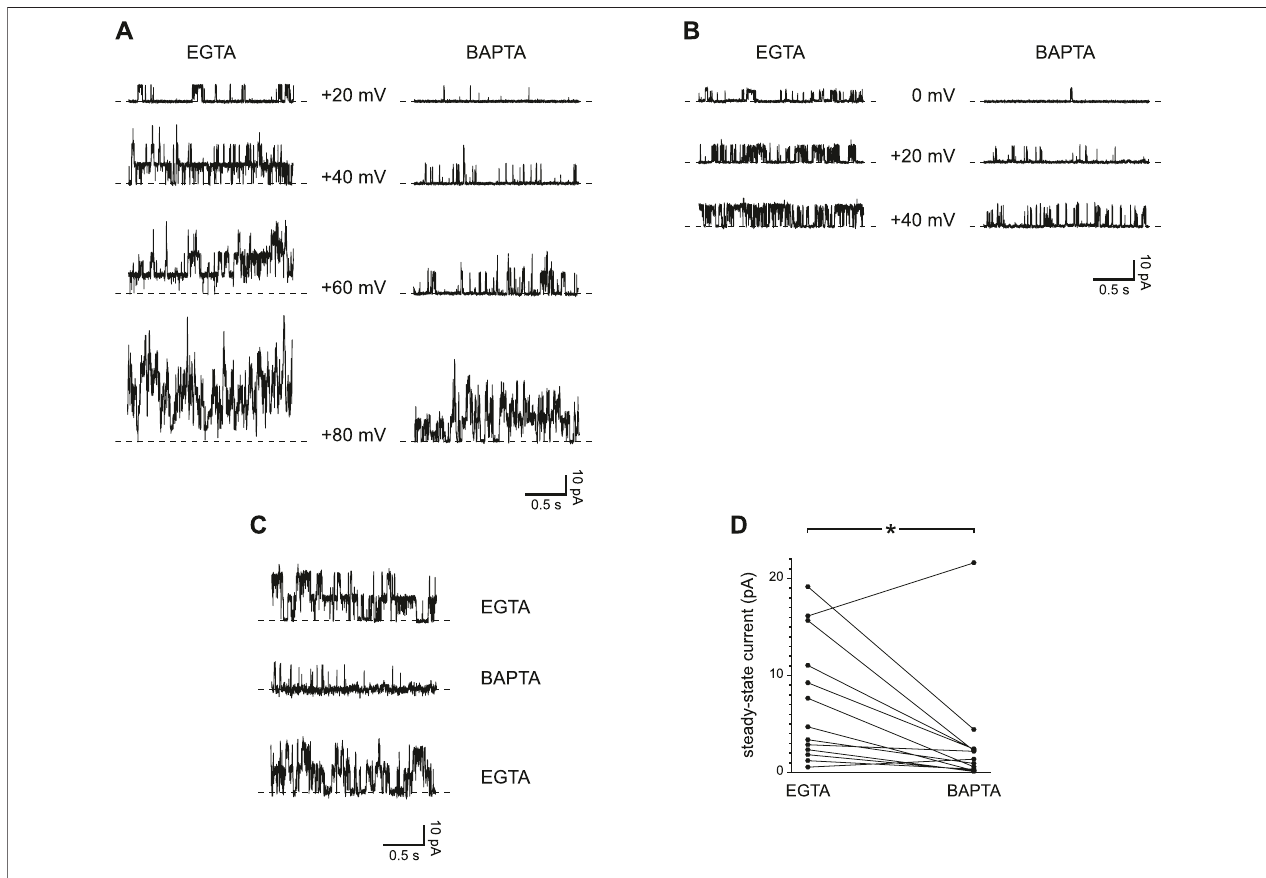
FIGURE 4 | Steady-state activity of PC2 channels is greater with slower Ca 2+ buffering (0.25 mM EGTA compared to 0.25 mM BAPTA). (A) Steady-state activity wasmeasuredinoneciliumatthevoltagesshownin0.25 mMEGTA(left)and0.25 mMBAPTA(right). (B) InaciliumwithjustonePC2channel,thechannelalsoshowed highersteady-stateactivityin0.25 mMEGTAthanin0.25 mMBAPTA. (C) TheeffectofslowerCa 2+ bufferingisreversible.Aciliumshowedhighersteady-stateactivityin 0.25 mM EGTA beforeand after exposure to0.25 mM BAPTA. Voltagewasmaintained at +60 mV. (D) Pairedmeansteady-state currents for13 cilia,each tested in both 0.25 mM EGTA and 0.25 mM BAPTA. Voltages were chosen that gave the greatest difference in mean current between 0.25 mM EGTA and 0.25 mM BAPTA and were in all cases +60 or +80 mV * p = 0.010.